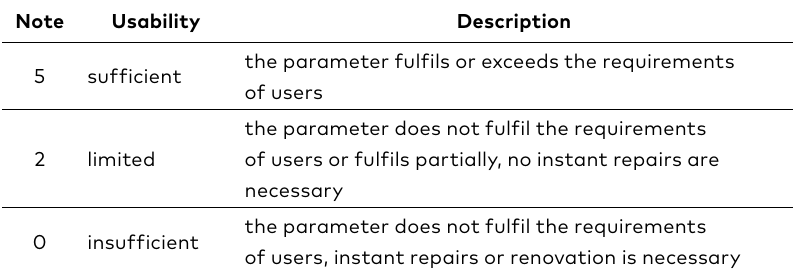
Table 2. Parameters values and corresponding criteria in “usability” assessment ( Directive 2005/14/GDDKiA